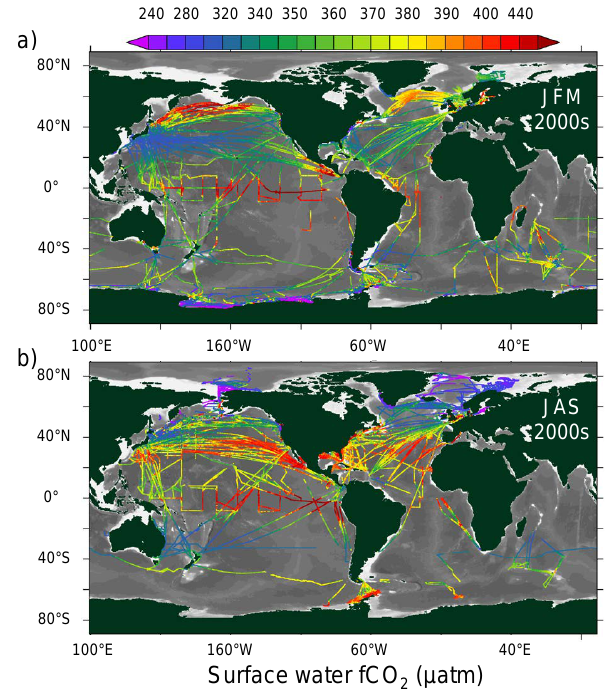
Figure 7. Seasonal distribution of surface water f CO 2 values for 2000 to 2009 in SOCAT version 2 for (a) January to March and (b) July to